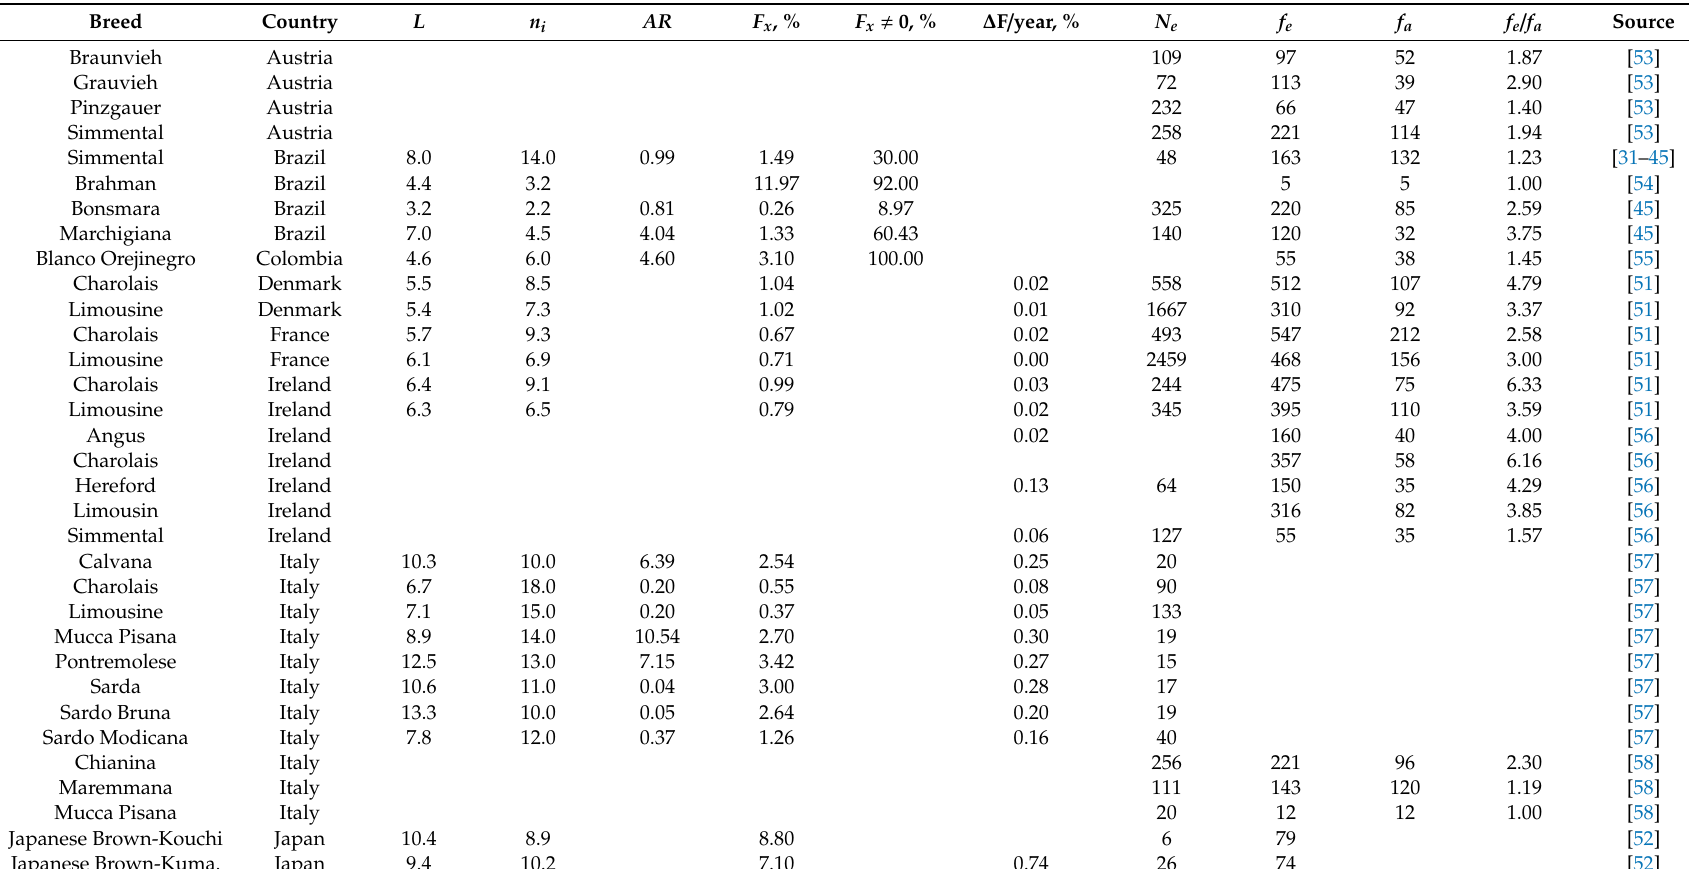
Table 4. Summary of demographic parameters reported for di ff erent cattle breeds, including generation intervals ( L ), number of generations known ( n i ), average relatedness ( AR ), average inbreeding ( F x ), percentage of inbred animals ( F x (cid:44) 0), e ff ective population size ( N e ), e ff ective number of founders ( f e ) and ancestors ( f a ), f e / f a ratio and rate of inbreeding per year ( ∆ F /